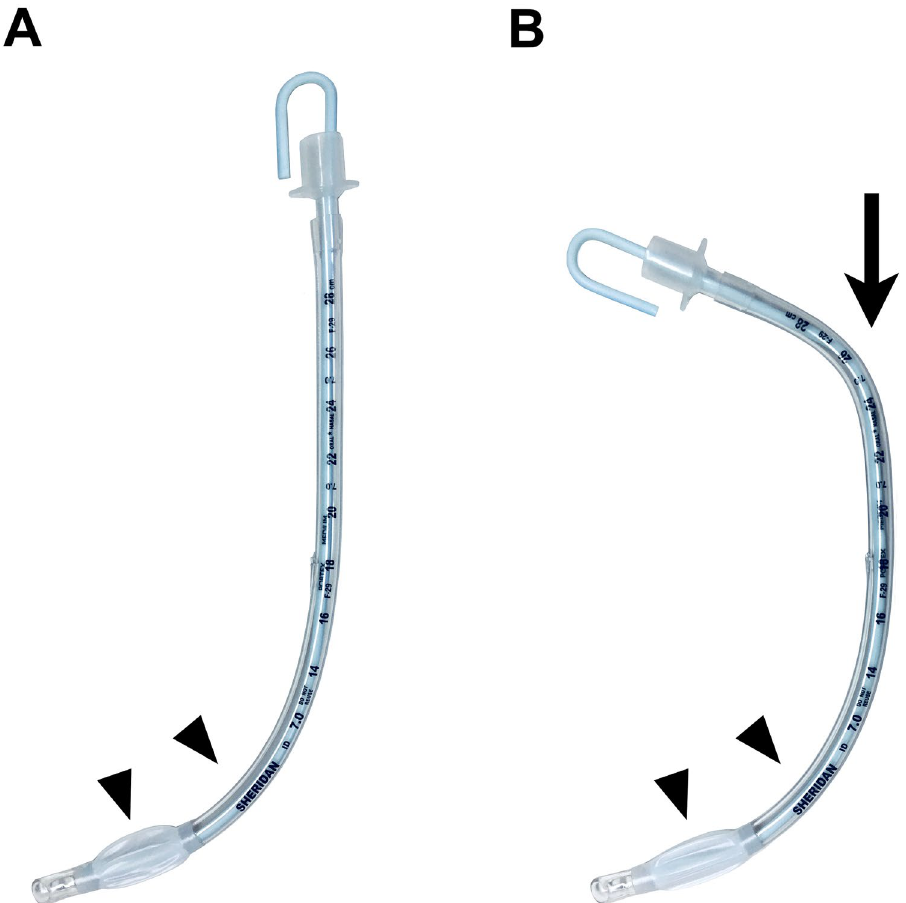
Figure 2. Stylet formation in each group in which tracheal intubation was performed using a malleable stylet with or without angulation at the operator’s holding position. ( A ) In the group without stylet angulation at the holding position, the stylet was only curved from the distal tip of the tracheal tube to 15.0 cm in alignment with the curvature of a McGRATH MAC disposable laryngoscope blade (arrowheads). ( B ) In the group with stylet angulation at the holding position, the distal segment of the stylet was curved as in the group without stylet angulation at the holding position (arrowheads) and 8.0 cm below the proximal tip was secondarily angulated 60° in the sagittal plane, which was configured to be the operator’s holding position